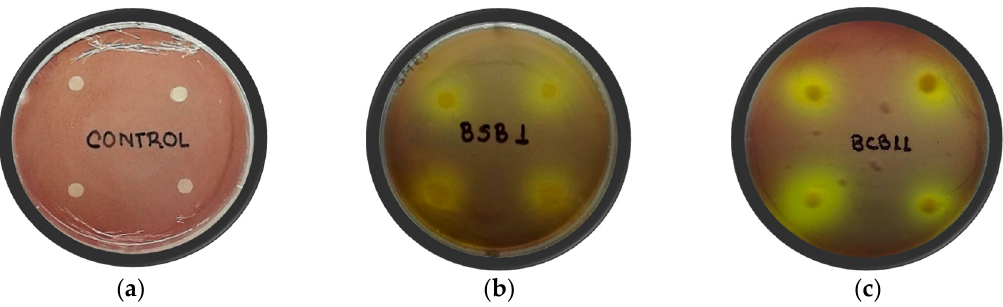
Figure 1. Inorganic phosphorus solubilization by rice-associated rhizobacteria, ( a ) untreated control, ( b ) inorganic phosphorus solubilization activity performed by BSB1, ( c ) inorganic phosphorus solubilization activity performed by BCB11 .